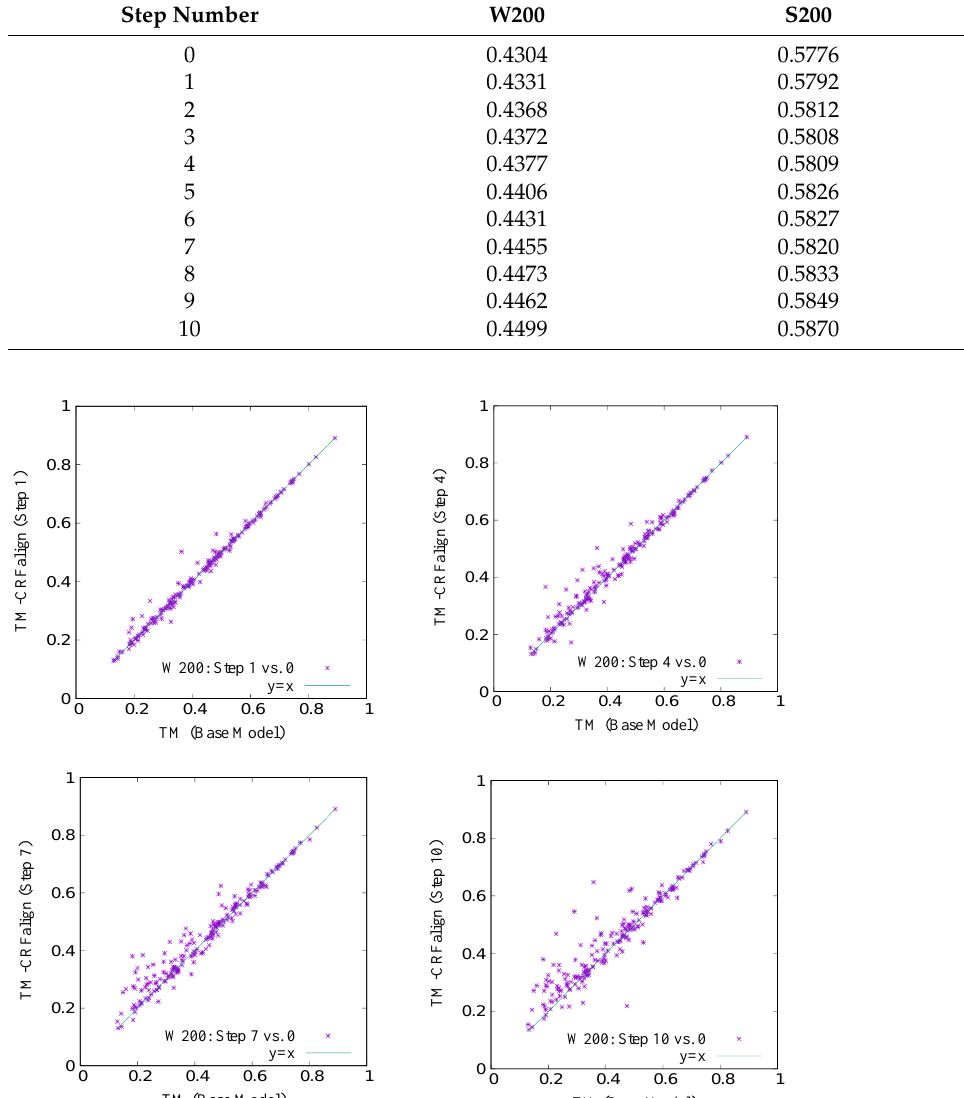
Figure 11. TM scores of structure models on the W200 test set with CRFalign (the five-state model) at steps 1 ( top left ), 4 ( top right ), 7 ( bottom left ), 10 ( bottom right ) vs. the Base model (step 0),